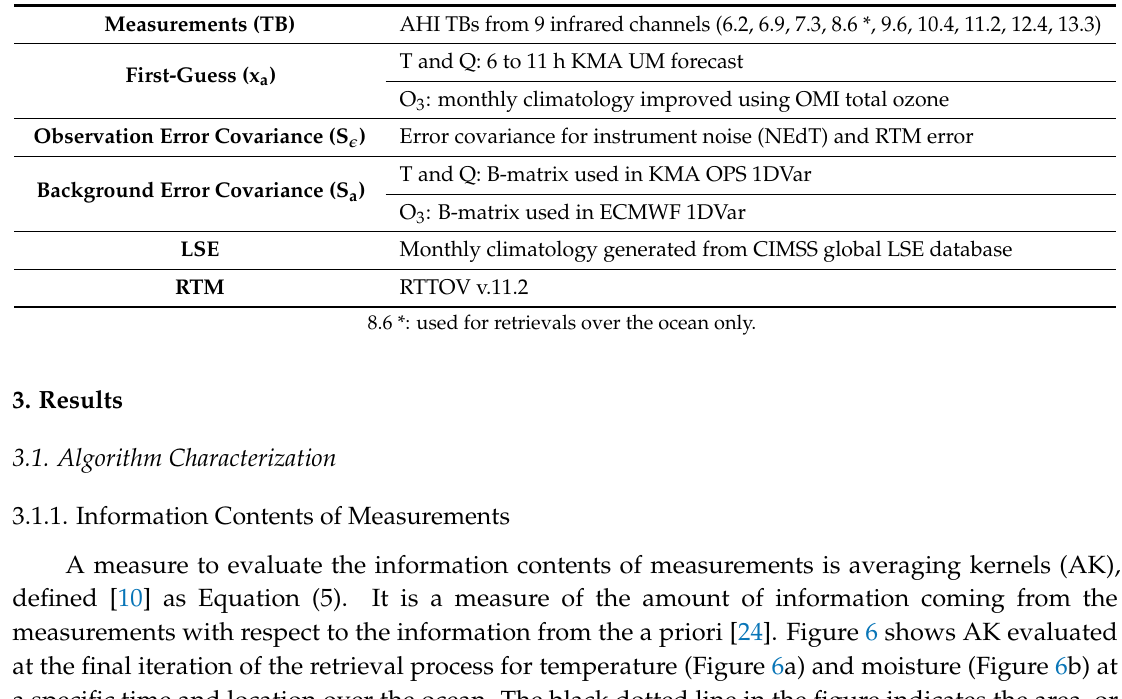
Table 2. Algorithm